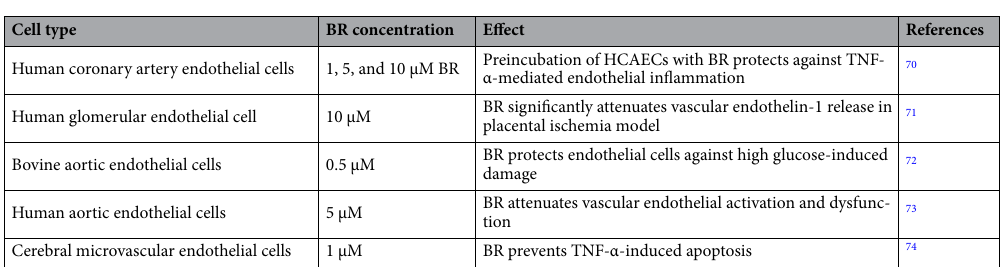
Figure 9. Knocking down biliverdin reductase does not aggravate HIER stress in EC cultures. HO-1 and biliverdin reductase A expressions were knocked down with small interfering RNAs, then ECs were exposed to heme (10 μM) for 2 h in serum- and antibiotics-free CM199. Then, the medium was changed to CM199 with 10% FCS and antibiotics. Relative expression of ( A ) BVRA, ( B ) CHOP, and ( C ) Grp78 mRNAs as well ( D ) spliced XBP1, CHOP, HO-1, and BVRA protein levels were analyzed 3 h after the heme treatment. In another set of experiments, BVRA was knocked down, then, ECs were treated with heme arginate as described above. Then, ECs were exposed to heme (25 μM) for 2 h in serum- and antibiotics-free CM199. Then, the medium was changed to CM199 with 10% FCS and antibiotics. Relative expression of ( E ) BVRA, ( F ) CHOP, and ( G ) Grp78 mRNAs as well ( H ) spliced XBP1, CHOP, HO-1, and BVRA protein levels were analyzed 3 h after the heme treatment. Data are shown as mean ± SEM of three independent experiments. Immunoblots are cropped from different parts of the same gel. Uncropped immunoblots are presented in the Supplementary information. Statistical analysis was performed by one-way ANOVA test followed by Bonferroni correction. A value of p < 0.05 was considered significant. * p < 0.05, *** p < 0.001.